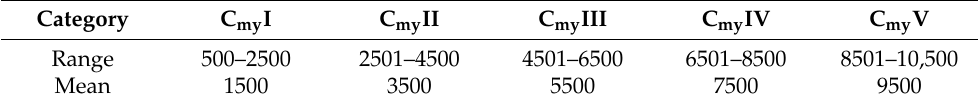
Table 5. Categories (C my ) of milk yield of cows, including data expressed in kg cow − 1 year − 1 .